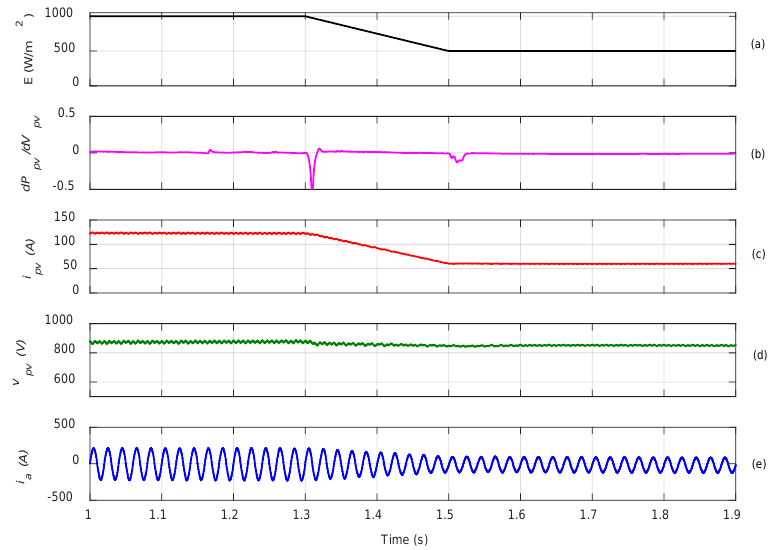
Figure 12. Irradiance ramp decrease: ( a ) irradiance, ( b ) power derivative, ( c ) photovoltaic current, ( d ) photovoltaic voltage, and ( e ) grid current, in case of proposed RCC-MPPT algorithm.